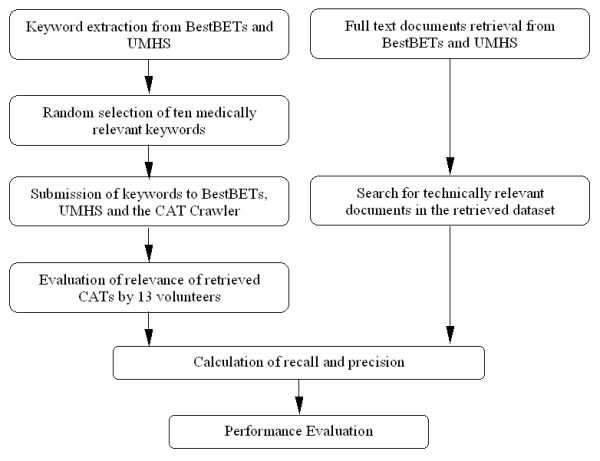
Workflow for evaluation of the CAT Crawler meta-search engine